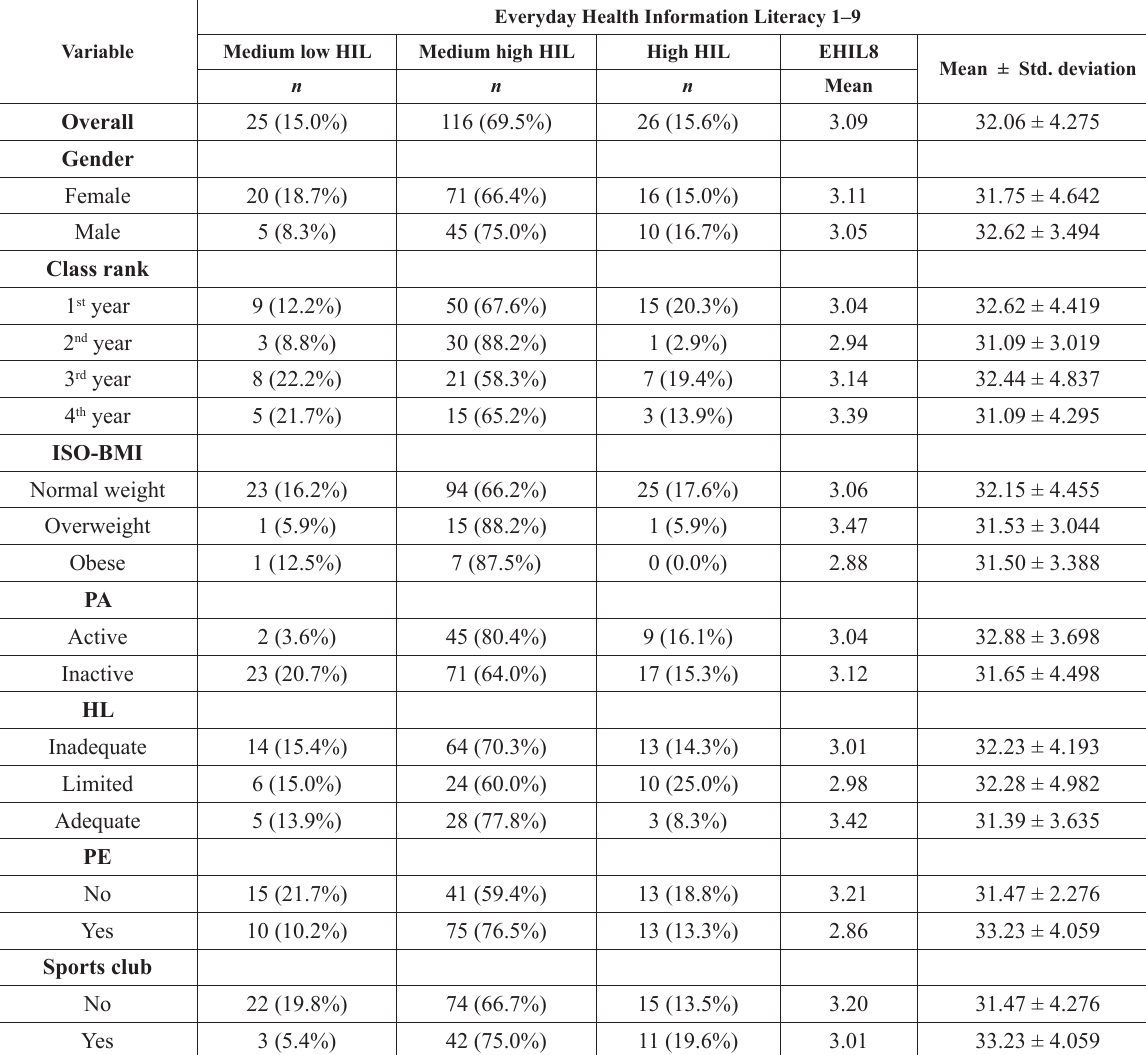
Table 2. EHIL1-9 score distribution by gender, class rank, ISO-BMI, PA, HL, PE and sports